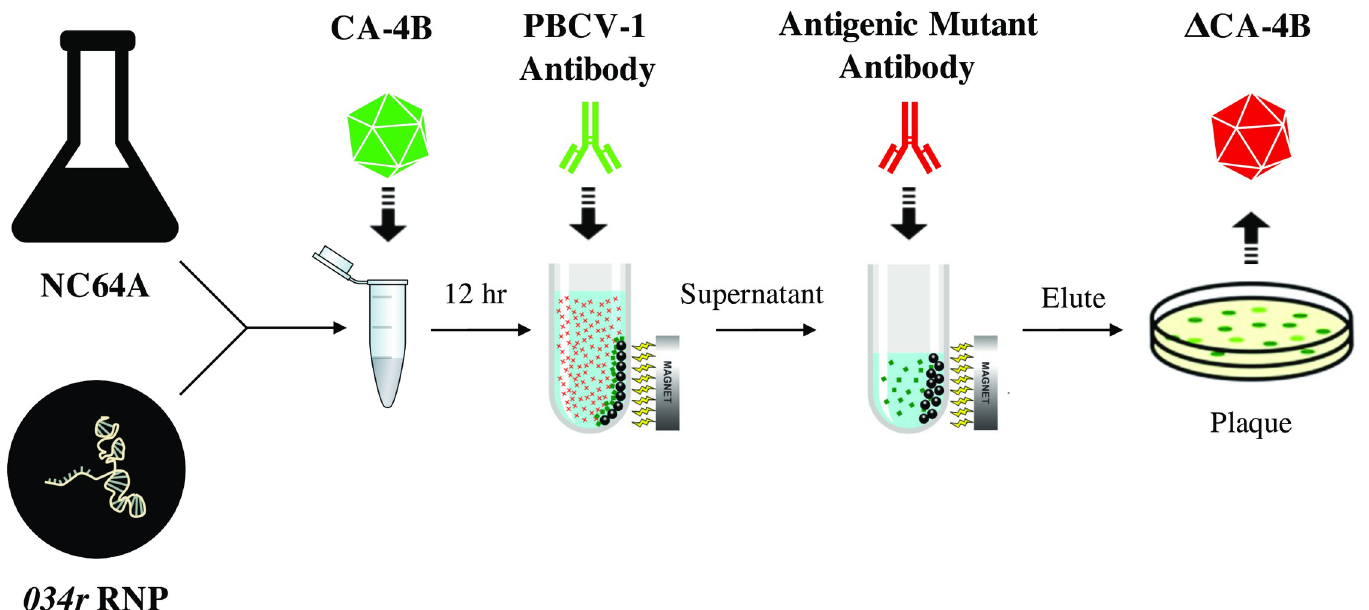
Fig 5. Workflow of antibody selection for mutant chloroviruses. Following incubation of macerozyme-treated NC64A cells with Cas9/sgRNA RNPs targeting the 034r gene, cells were infected with CA-4B (MOI 5). Rabbit polyclonal antiserum (PBCV-1 antibody, green) was added to the viral-induced cell lysate to interact with wild-type viruses. Goat anti-Rabbit IgG magnetic beads were incubated with the rabbit antibody solution and then separated using magnets. The unbound viruses were collected and subsequently incubated with antibody derived from serologically distinct PBCV-1 mutants (antigenic mutant antibody, red) that have shortened surface glycans. Magnetic beads were incubated again with the antibody solution and then separated using magnets. Bound mutant viruses were eluted from the beads and plaque assayed.